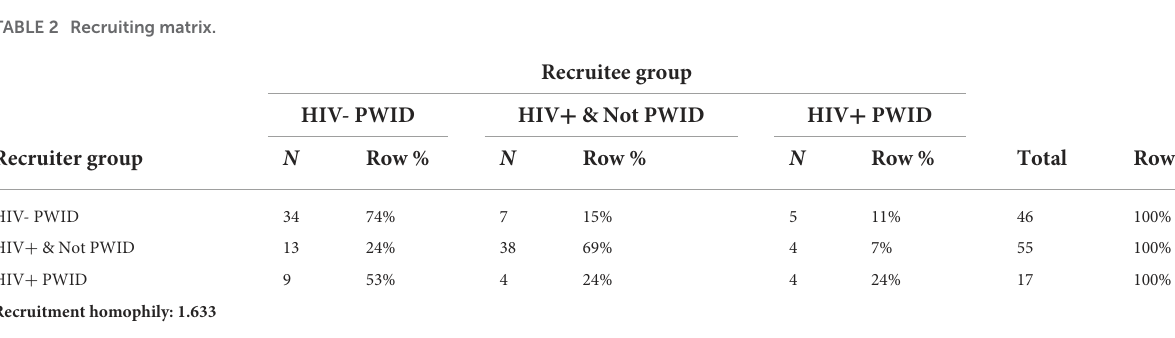
TABLE 2 Recruiting